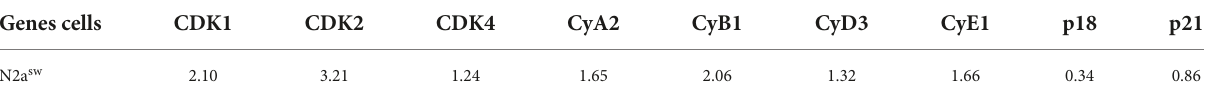
TABLE 2 The expression of cell cycle-associated genes in N2a sw cells.